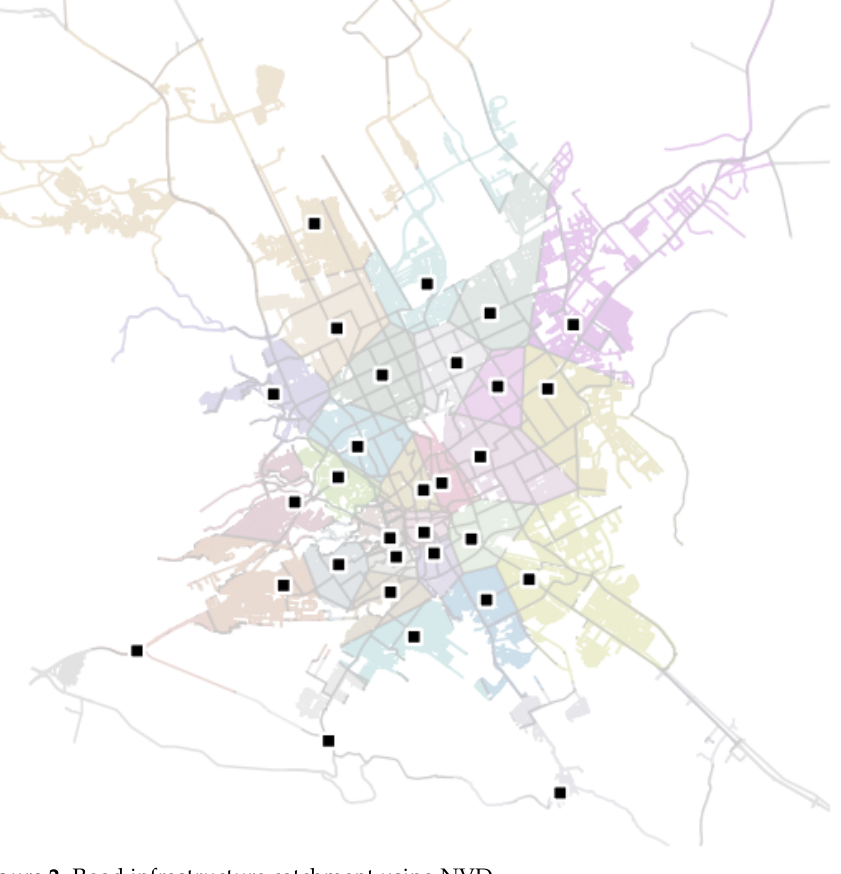
Figure 2. Road infrastructure catchment using